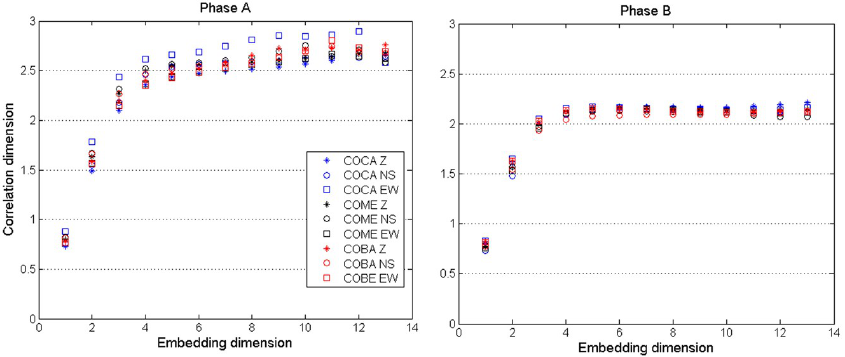
Fig. 6. Correlation dimension versus embedding dimension for two representative samples from Phase A (09/12/2005 13:00) and Phase B (14/02/2006 13:00). All the available stations and all the ground motion components have been analysed. The correlation dimensions have been estimated as the slopes of the correlation integral as function of the scaling parameter l (see Eq. 1). The correlation dimension converges to different limit values for the two phases, which are in the range of 2.7–3 for Phase A and 2–2.2 for Phase B.